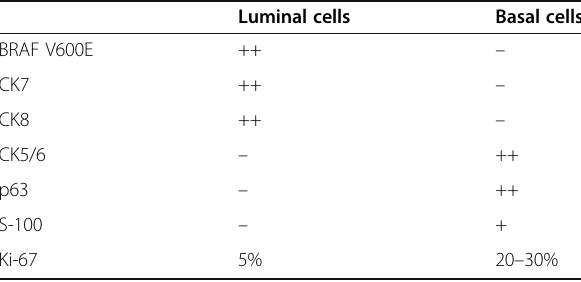
Table 2 Immunohistochemical findings of sialadenoma papilliferum (our five